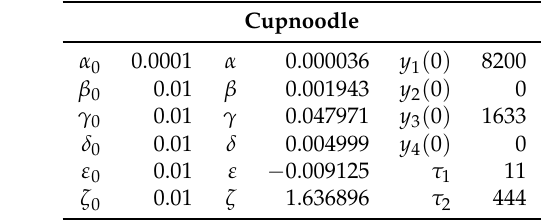
Figure 4. Fitting to Cup-noodle data. Table 4. Various parameter